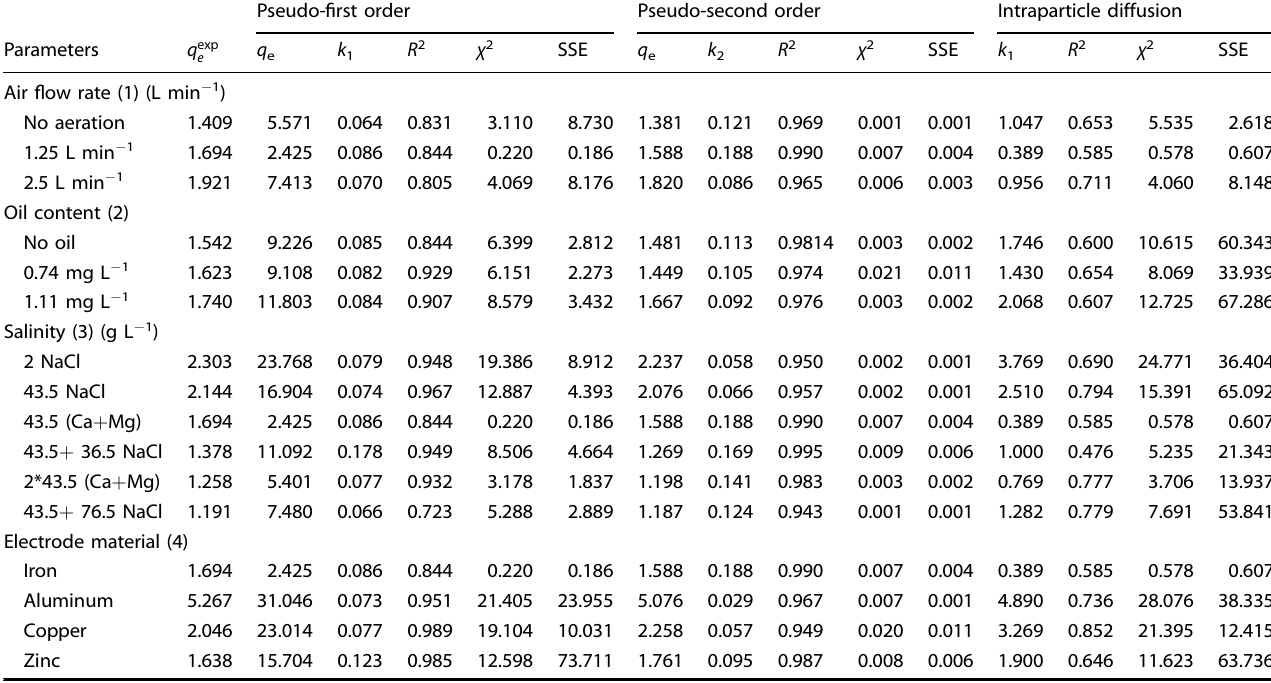
Table 2. The parameters of the kinetic models at various operating conditions. Pseudo- fi rst order Pseudo-second order Intraparticle